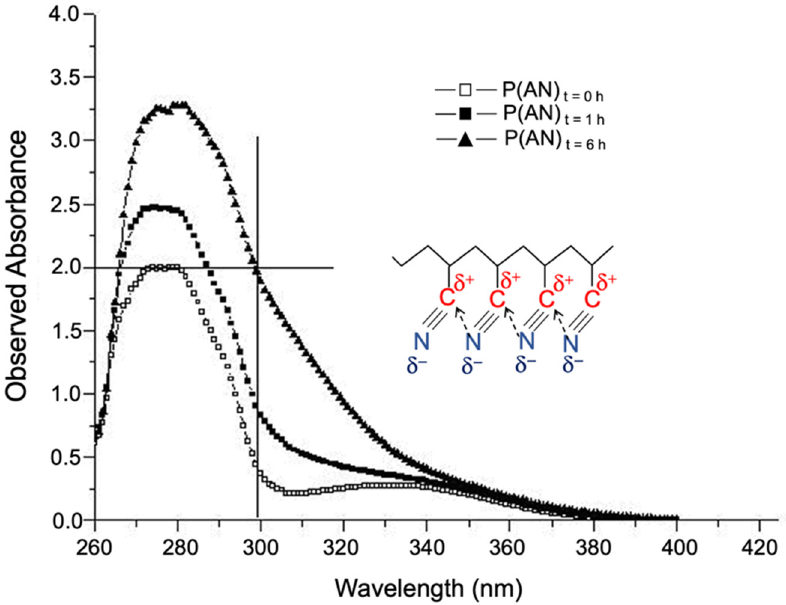
Figure 6. UV-Vis spectra of AN monomer in DMF before polymerization ( □ ), after 1 h of polymeri- zation ( ■ ), after 6 h of polymerization ( ▲ ).